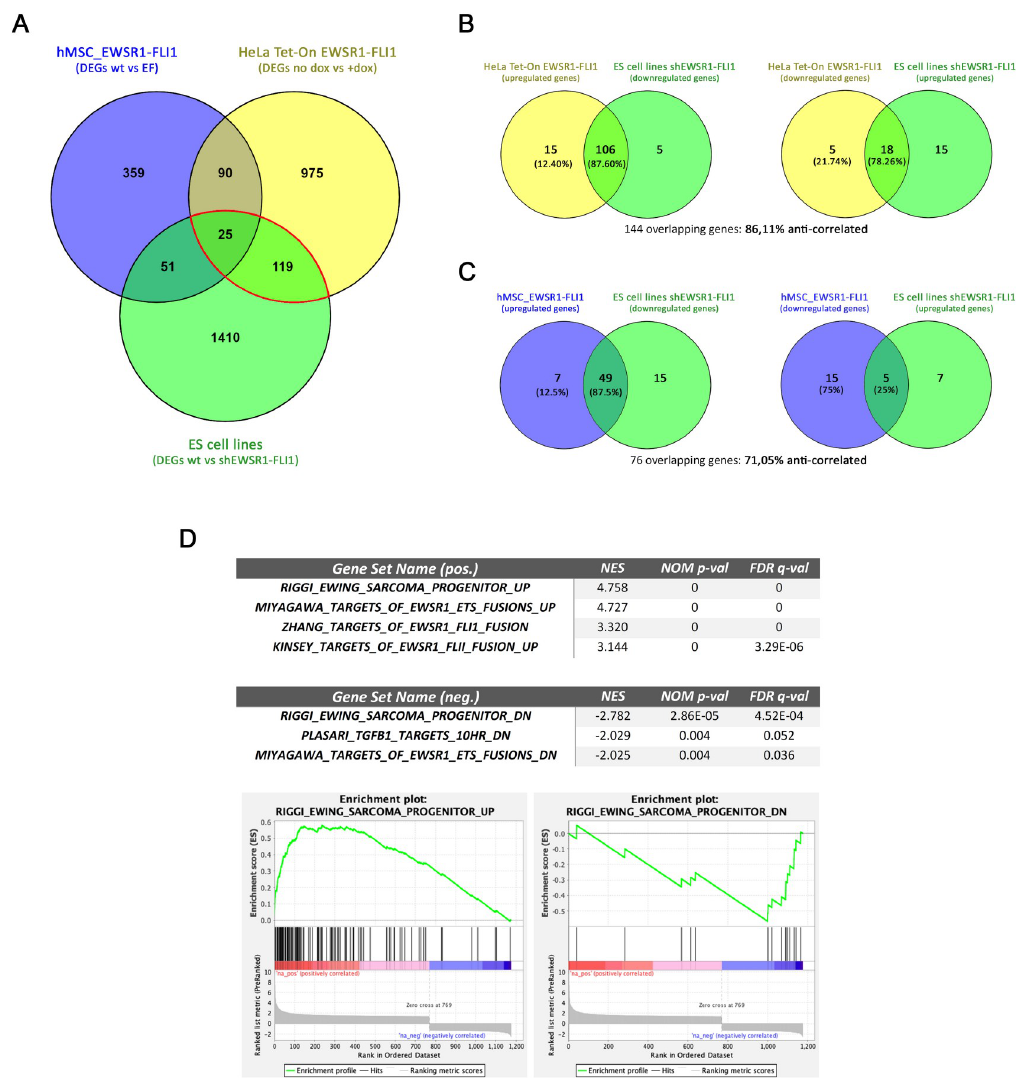
Fig 4. HeLa Tet-On EWSR1-FLI1 gene expression patterns correlated with different published models. A. Venn diagram analysis of differentially expressed genes between HeLa Tet-On EWSR1-FLI1, hMSC_EWSR1-FLI1 and the ES cell line shEWSR1-FLI1. B. Venn diagrams showing the overlap between upregulated genes in the HeLa model and downregulated genes in ES cell lines shEWSR1-FLI1 (and vice versa ). C. Overlapping genes between hMSC_EWSR1-FLI1 and shEWSR1-FLI1 ES cell line models are shown in analogous Venn diagrams. D. MSigDB analysis of genes that were significantly and at least 1.3-fold repressed or induced by EWSR1-FLI1 ectopic expression in HeLa cells shows marked overlap with EWSR1-FLI1 target genes (top). The enrichment plots with the best enrichment score are shown as |NES| (bottom). NES, the normalized enrichment score. [16] as well as from five ES cell lines in which the protein fusion was ectopically expressed or depleted by shRNA system [24]. A Venn diagram showed 144 overlapping genes between our HeLa model and the five ES cell lines in which the EWSR1-FLI1 was depletion (the ES cell lines shEWSR1-FLI1), and only 76 common genes between hMSCs that ectopically expressed the fusion protein (hMSC_EWSR1-FLI1) and shEWSR1-FLI1 cell lines (Fig 4A). In addition, analyzing the 144 genes shared by the HeLa model and ES cell lines shEWSR1-FLI1, we con- firmed that most upregulated genes in the HeLa model matched with the downregulated genes